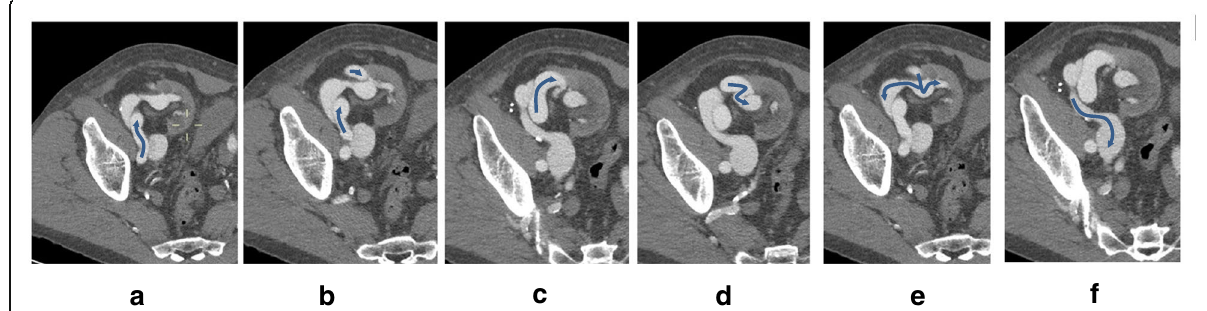
Fig. 2 Series of CTA images demonstrating high flow arterio-venous fistula within the transplanted kidney. Block arrow demonstrating route of blood from transplant artery (images a-d ), the AV fistula (image e ) and the early filling of the transplant renal vein (image f )